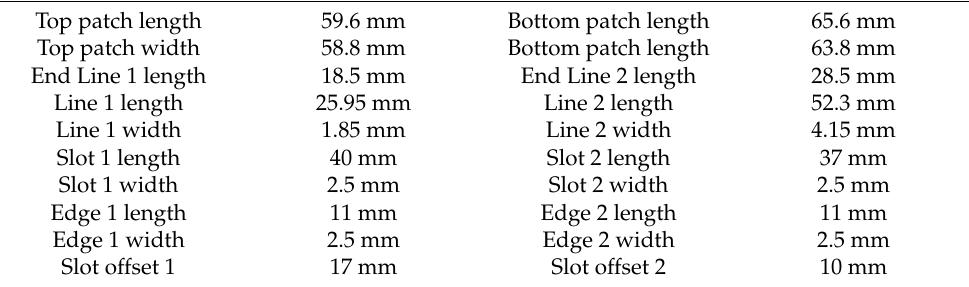
Table 2. Antenna geometrical values.